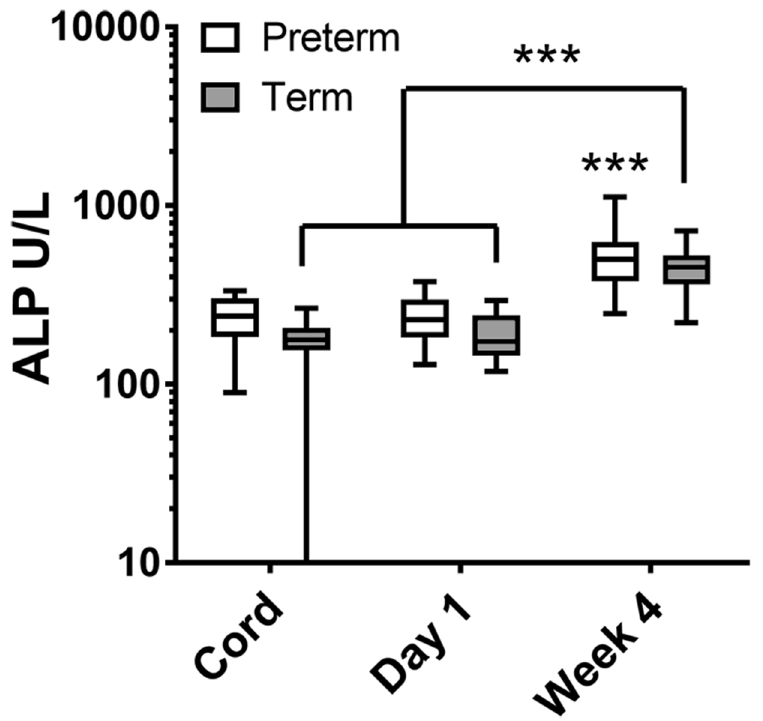
Fig 3. Plasma ALP increasessignificantly in the first 4 weeks of life for both pre-term and term newborns. Comparisonswere made by ANOVA with Bonferroni multiple comparisoncorrection (statistical results for comparisonto early time points in both populations).Only subjectswithout HCA or LOS were included, N = 11–16 for term, N = 12–36 for pre-term. *** p <